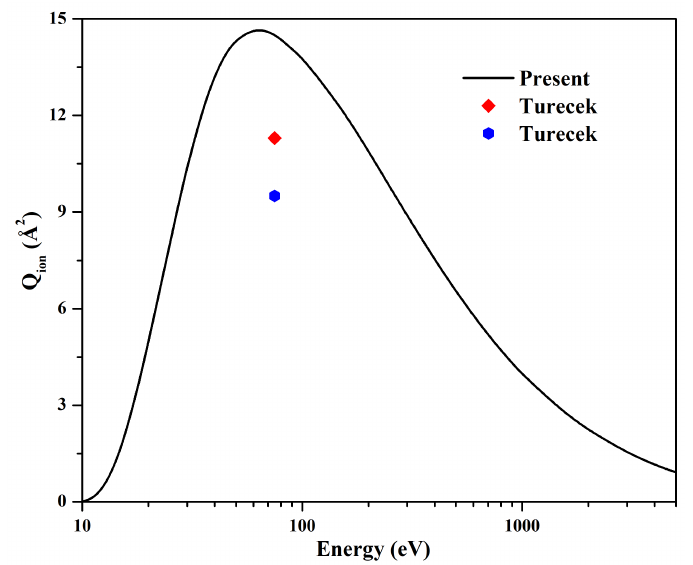
Figure 7. Q ion for cyclobutanone. Solid line: present Q ion for cyclobutanone; solid rhombus: theo- retical Q ion calculated for cyclobutanone by Tureˇcek et al. [12]; solid hexagonal: experimental Q ion calculated for cyclobutanone by Tureˇcek et al.